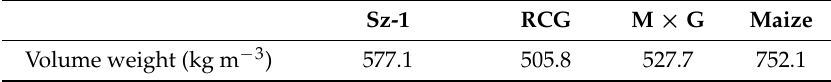
Table 17. Average values of volume